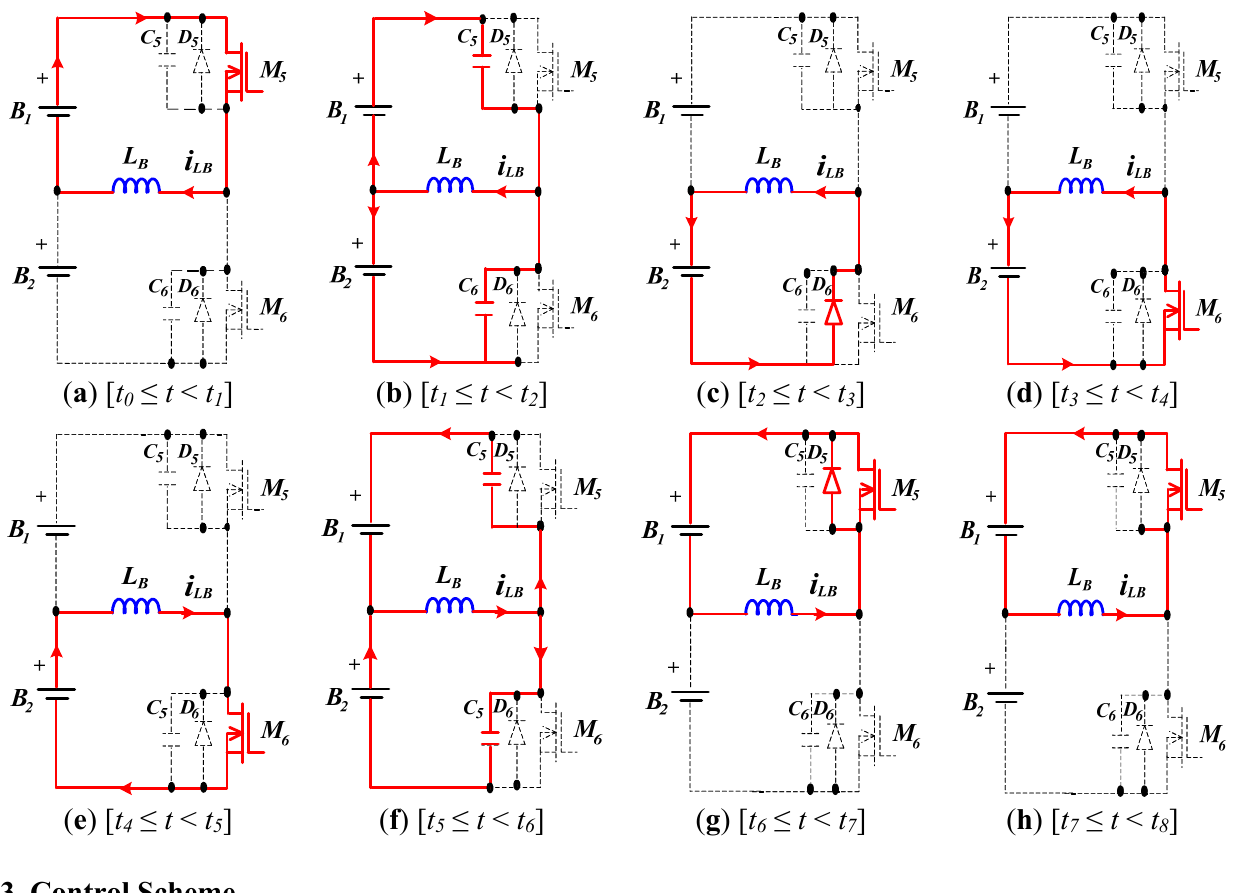
Figure 9. Equivalent circuits of operating stages for voltage equalization